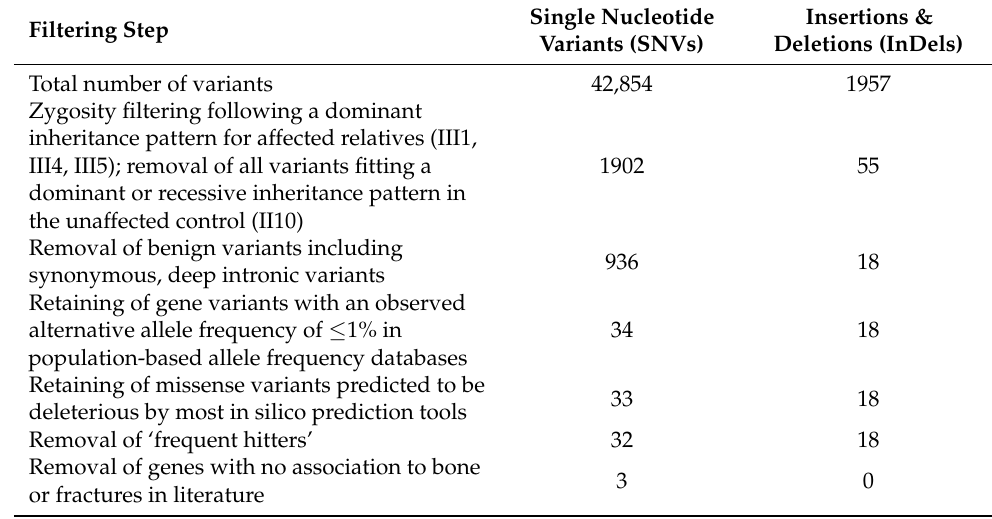
Table 2. Sequential filtering steps applied to the merged vcf files of the SNVs and Indels.